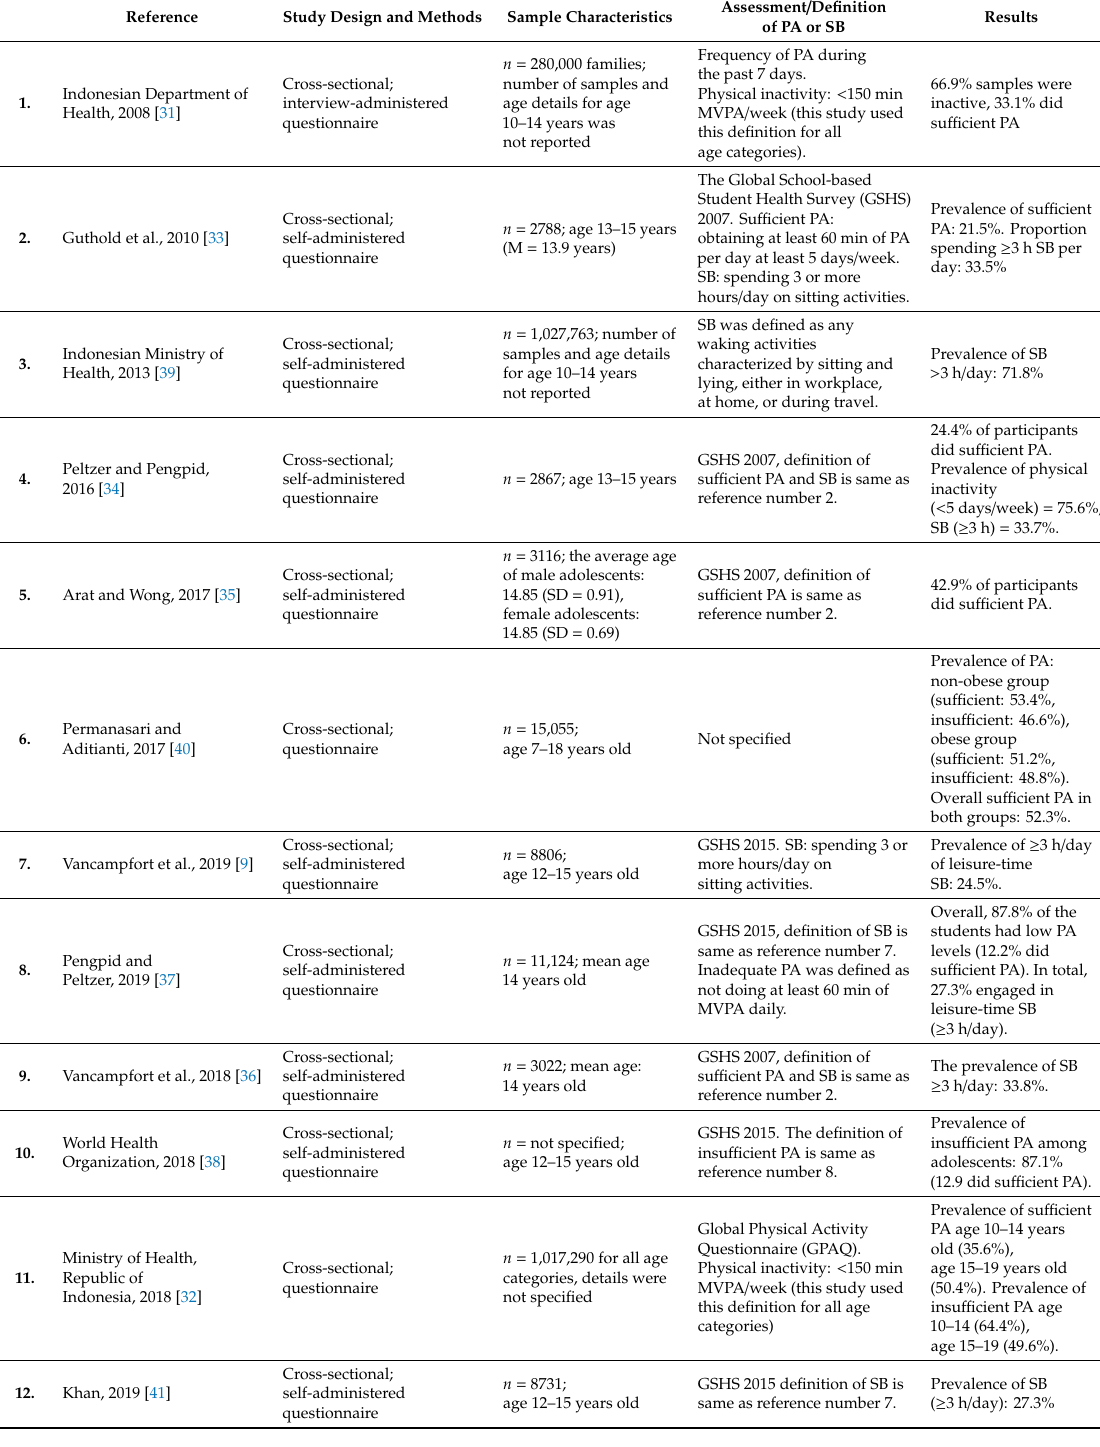
Table 2. Prevalence of physical activity (PA) and sedentary behavior (SB) in Indonesian youth from nationally representative